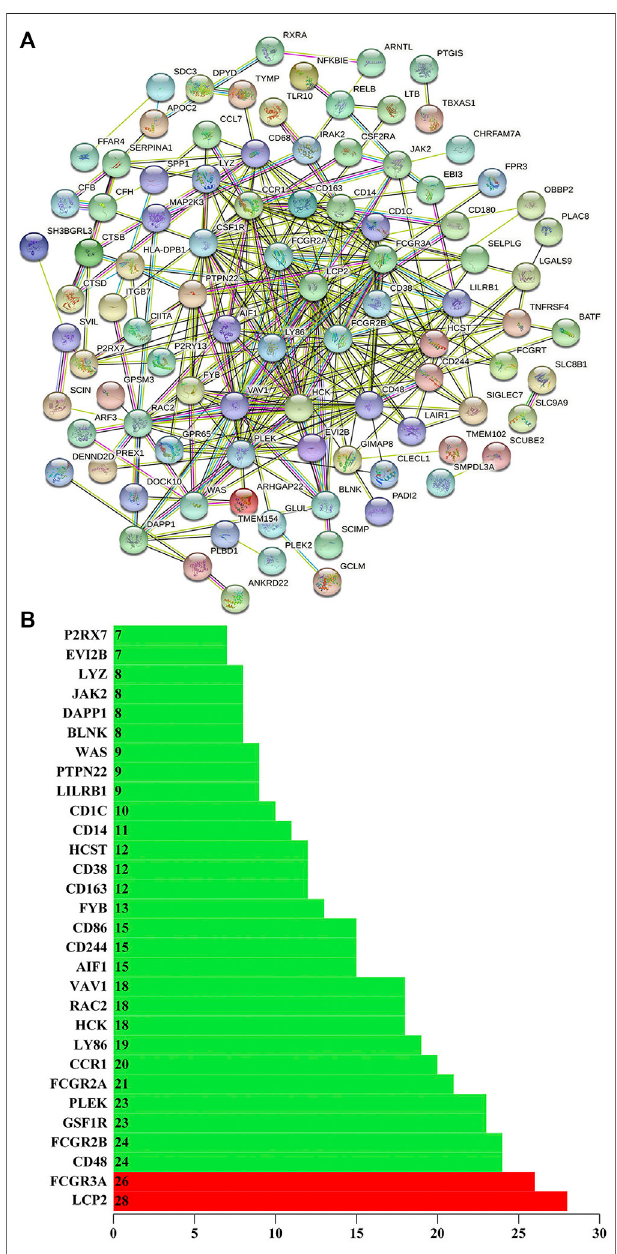
FIGURE 5 | (A) Using the STRING (https://string-db.org/) to build the protein interaction network of key genes. (B) The number of edges of key genes through the protein interaction network. The X -axis represents the total number of edges connected by genes, and the Y -axis represents the gene